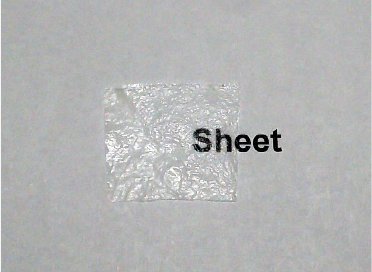
Figure 2. The appearance of a sheet with uniformly dispersed compound-loading sites (the letters “S” and “h” in the word “Sheet”, written on paper, can be seen through the transparent